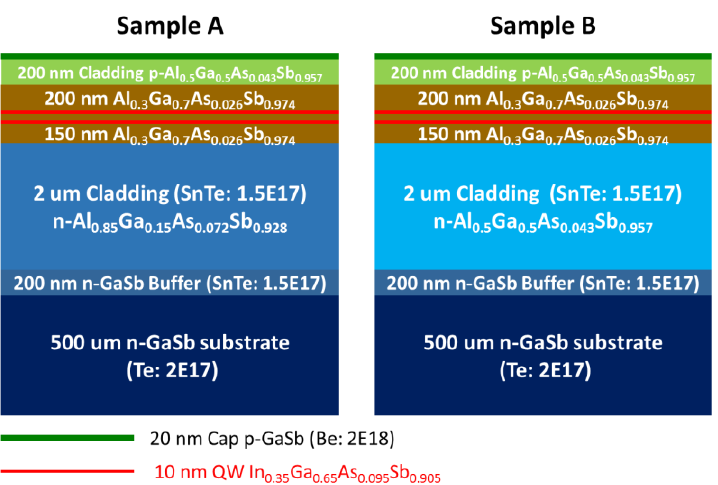
Figure 2. Schematic diagrams of two different type-I InGaAsSb/AlGaAsSb quantum well (QW)/barrier laser structures (samples A and B) for application in photonic crystal surface-emitting laser (PCSELs). The only difference between the two devices was the composition of the n -cladding layer.